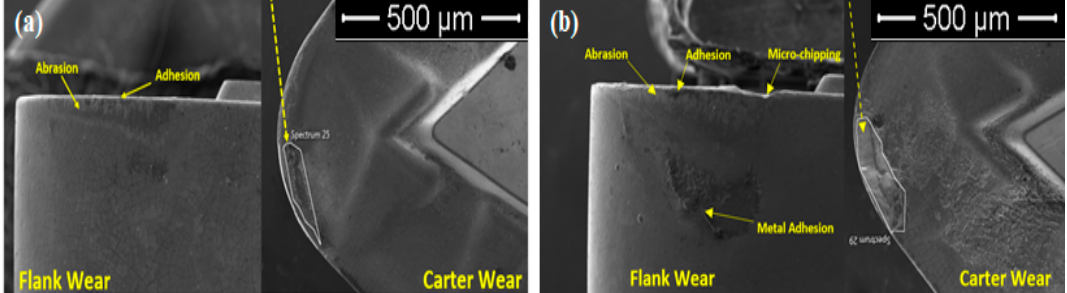
Table 2. Experimental results .